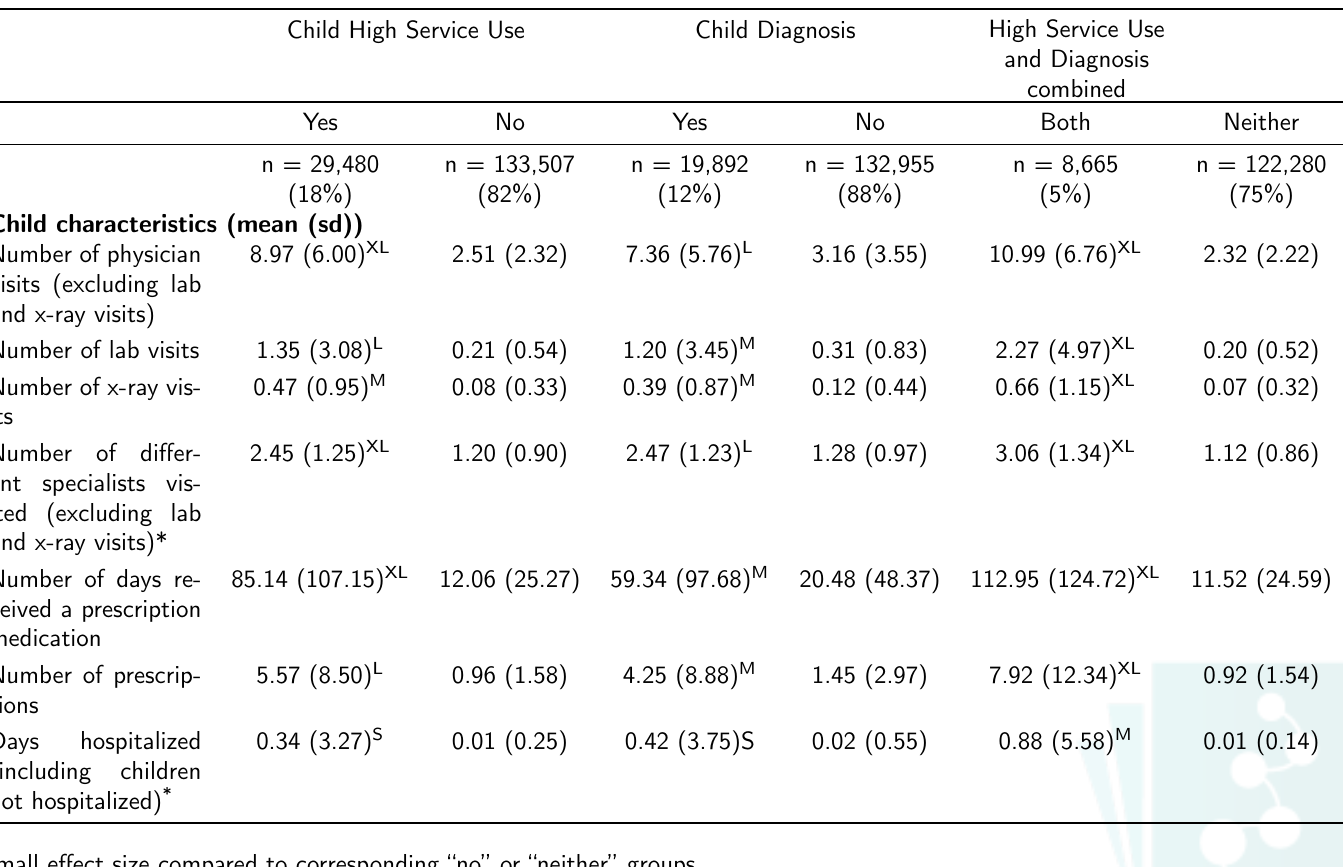
Table 2: Validation of child health